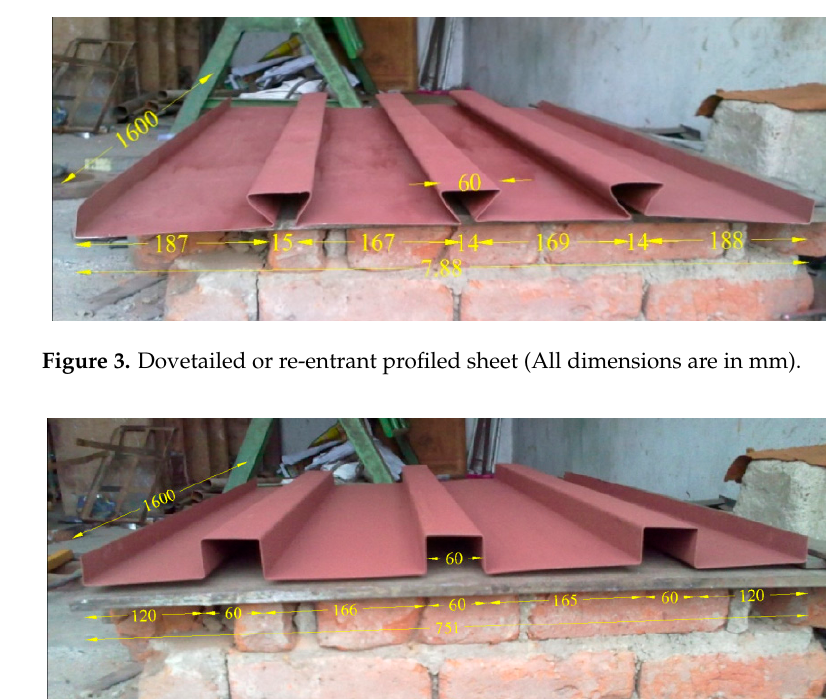
Figure 2. Cross sectional dimensions of profiled sheet.